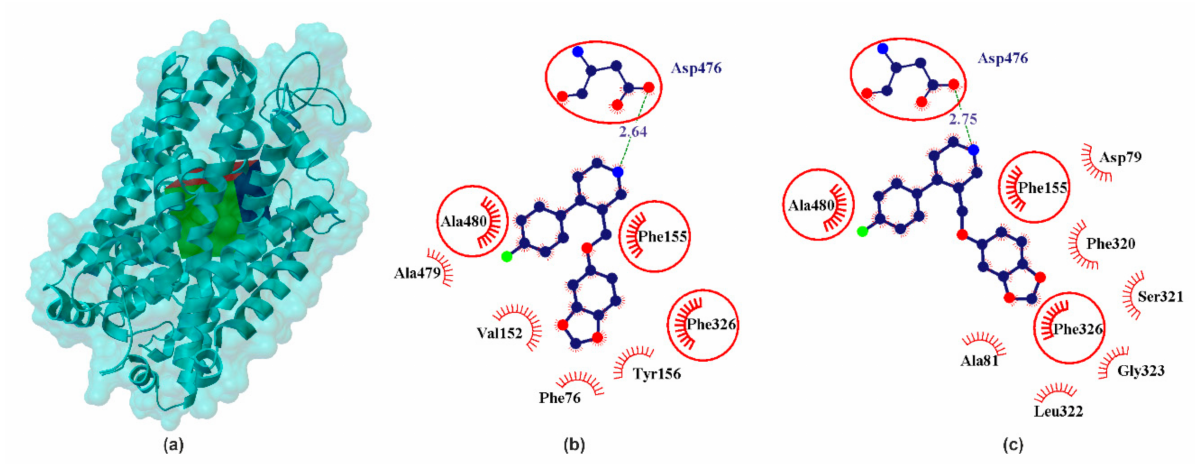
Figure 3. X-ray structure of the hDAT homology model ( a ) with the grid box showing the ligand-binding site (Swiss-Prot ID: Q01959) and calculated data for cocaine binding pocket ( b ) and clomipramine binding pocket in PRX–hNET complex ( c ). The red circles and ellipses identify equivalent residua (in 3D superposition of